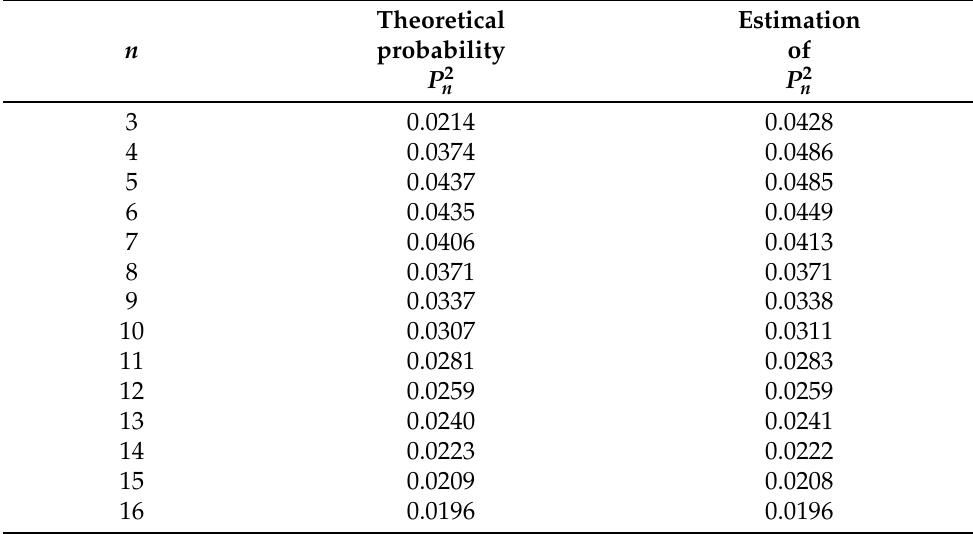
Figure 10. Comparison between the theoretical probabilities P 2 n of Proposition 3 and its estimate (cid:100) ( P 2 n ) . Table 8. Comparison between the theoretical probabilities P 2 n of Proposition 3, and its estimation (cid:100) ( P 2 n )